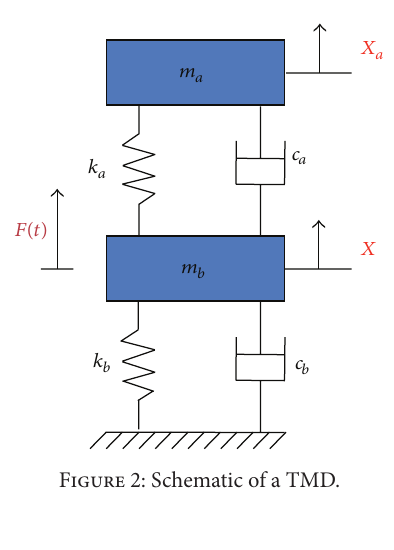
Figure 2: Schematic of a TMD.